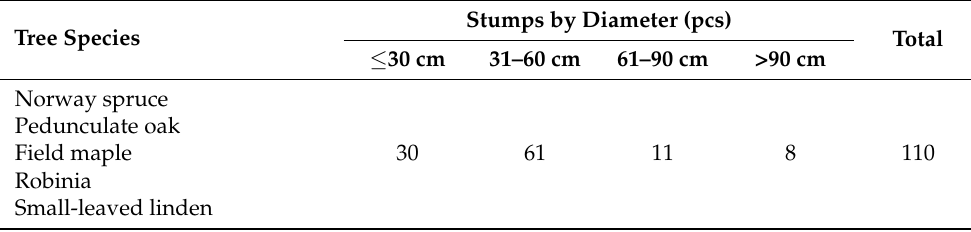
Table 3. Species representation and stumps by diameters—LHC Str á žnice, district of Rat í škovice. Tree